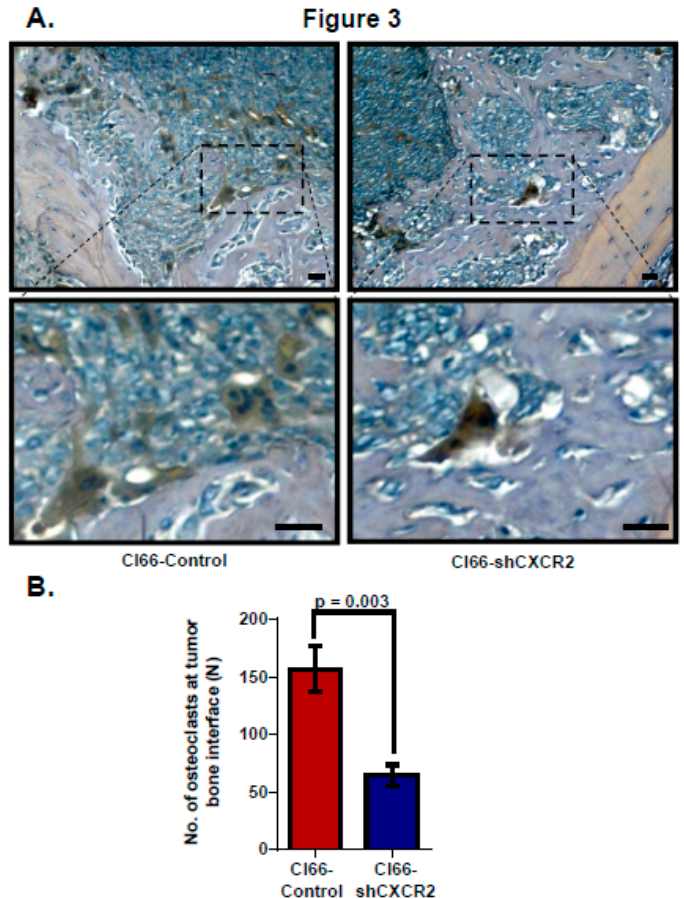
Figure 3. CXCR2 downregulation in tumor cells lowers activated osteoclast number at the tumor-bone interface. ( A ) Representative images of osteolytic activity as determined by TRAP staining at the tumor-bone interface from Cl66-Control and Cl66-shCXCR2 tumor-bearing mice. Scale bar represents 10 µ m ( B ) Bar graph showing a significantly lower number of TRAP-positive osteoclasts in Cl66-shCXCR2 (65 ± 9) in comparison with the Cl66-Control tumor group (157 ± 12) ( n = 5, p = 0.003) at the tumor-bone interface.